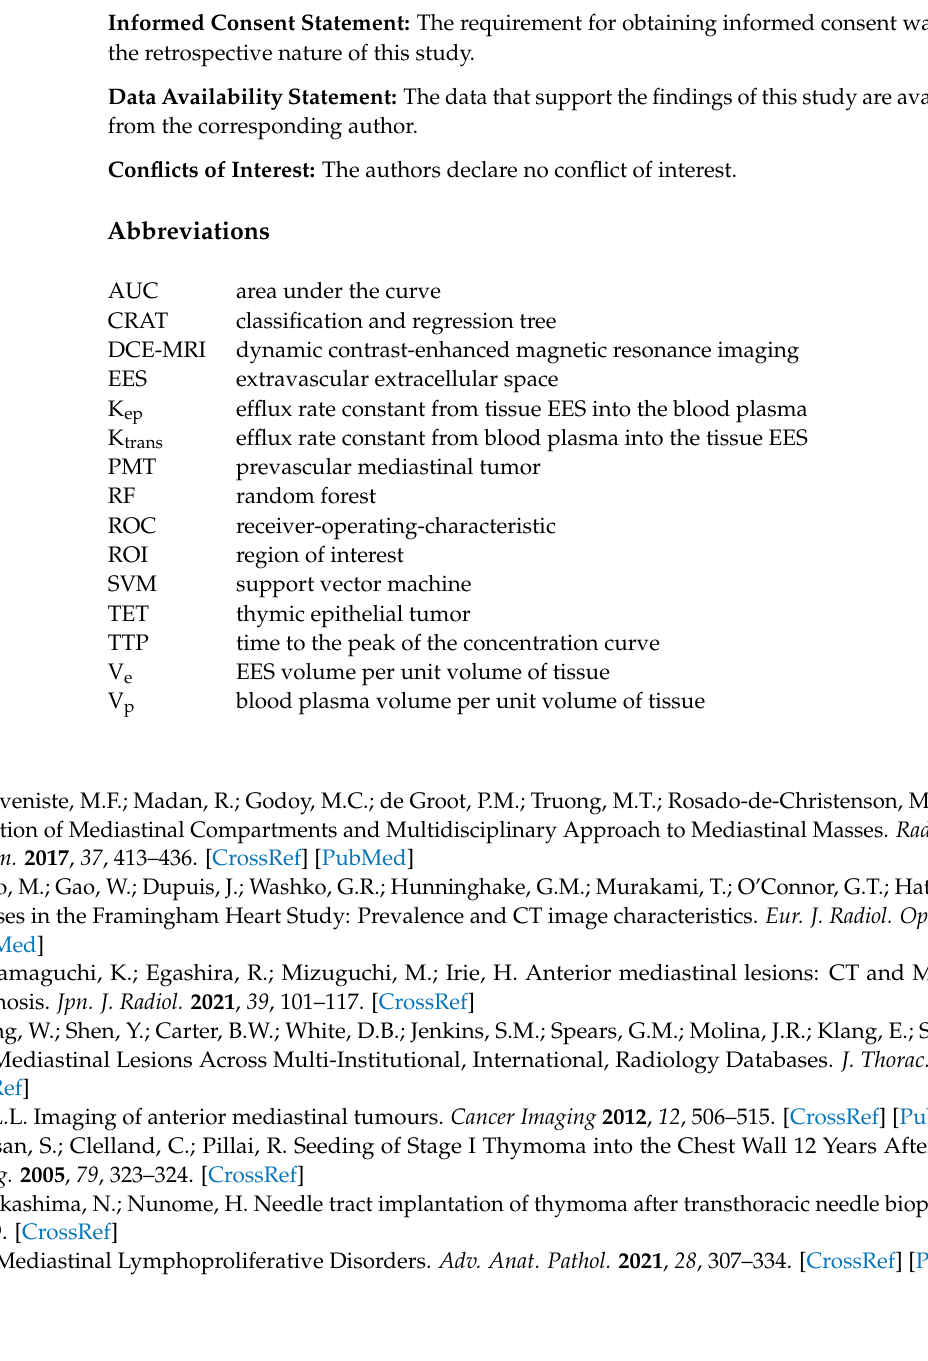
classification of PMT subtypes; Table S4: Polytomous logistic regression among all 62 patients to evaluate PMT subtypes with selected parameters derived from the decision